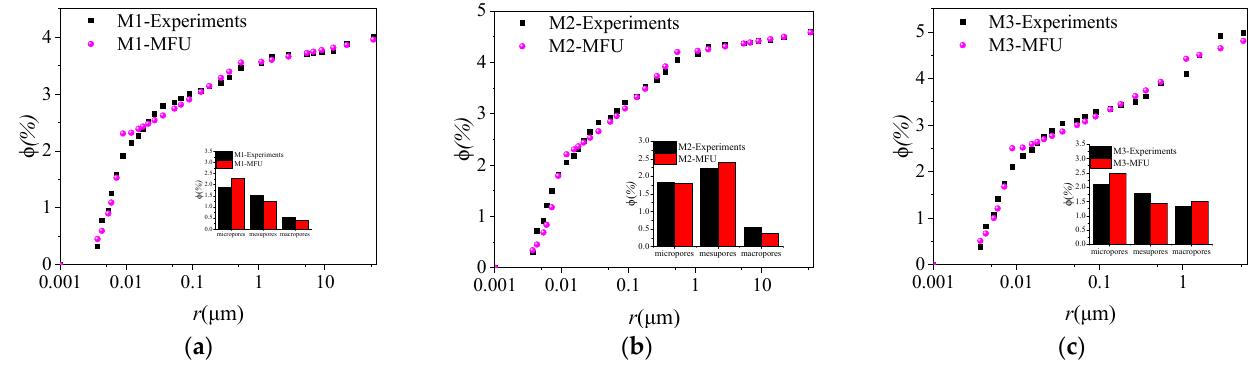
Figure 9. Permeability contribution curves of coal samples based on MIP. M1, M2, and M3. 4.3. Comparison of the Pore Structure from MFU and Experiments The comparison of the pore structure distribution obtained by MFU and experimental data is shown in Figures 10 and 11. The distribution of micropore, mesopore, macropore all have the same trend. The curves and column charts show that the pore radius distribution of MFU can better fit the experimental data, which provides a basis for predicting permeability. The comparison result of the pore structure can ensure the correction of the predicting permeability and save time for next work.